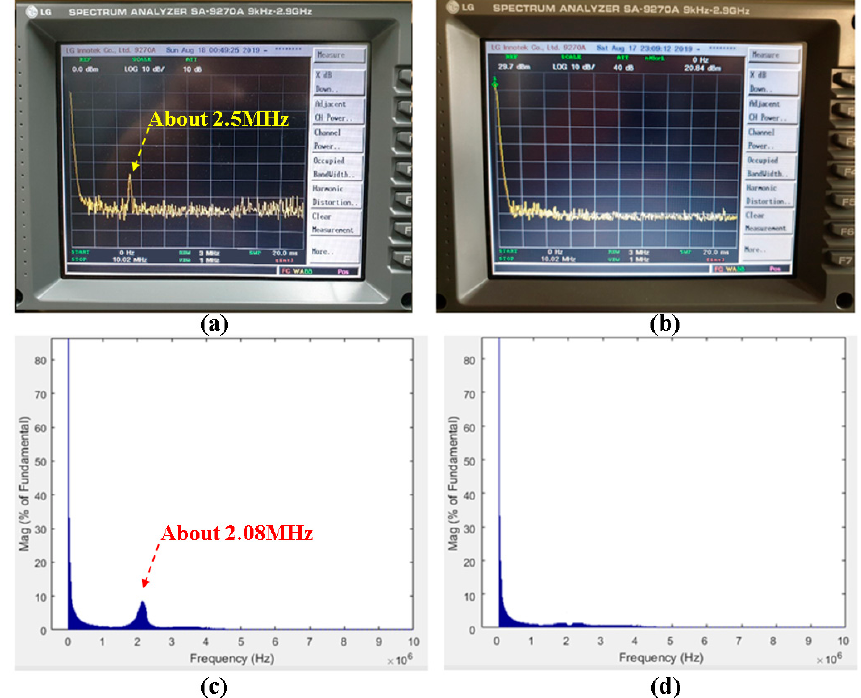
Figure 19. The comparison of signal spectrum before and after applying the proposed method. ( a ) System response spectrum measurement results before method applied; ( b ) System response spectrum measurement results after method applied; ( c ) System response spectrum simulation results before method applied; ( d ) System response spectrum simulation results after method applied.